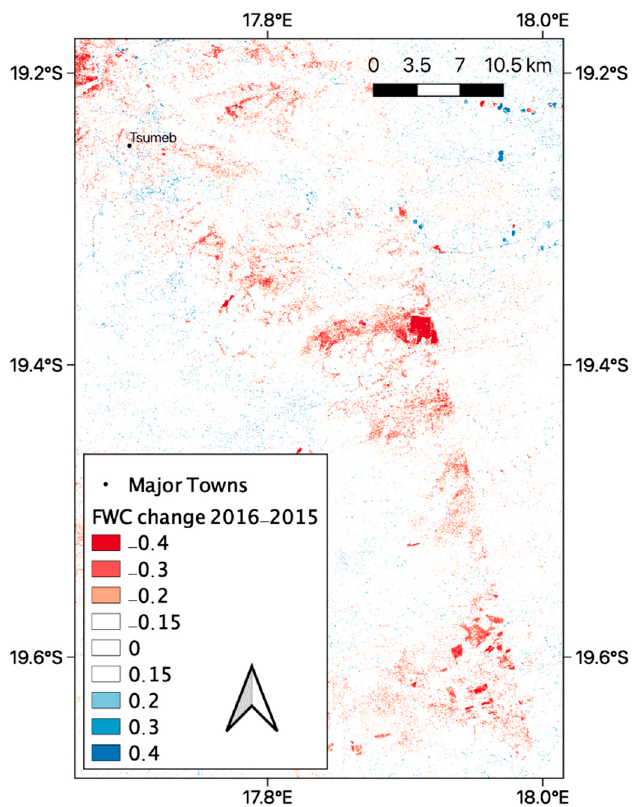
Figure 17. FWC Δ 2016–2015 displaying a banding anomaly caused by contrasting surface moisture conditions and resulting backscatter in adjacent strips of 2015 ALOS PALSAR global mosaic.